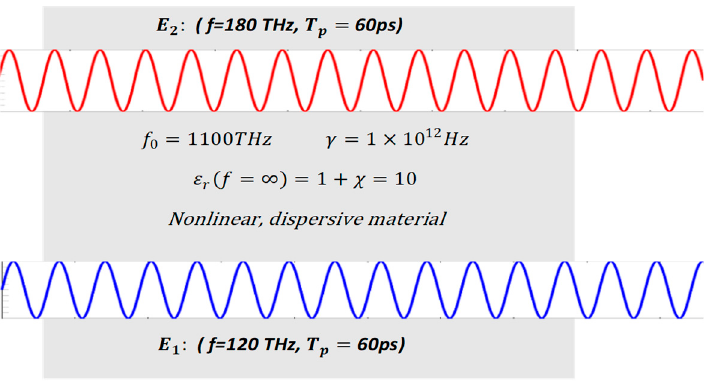
Figure 8. Configuration for the frequency up-conversion in example 1.